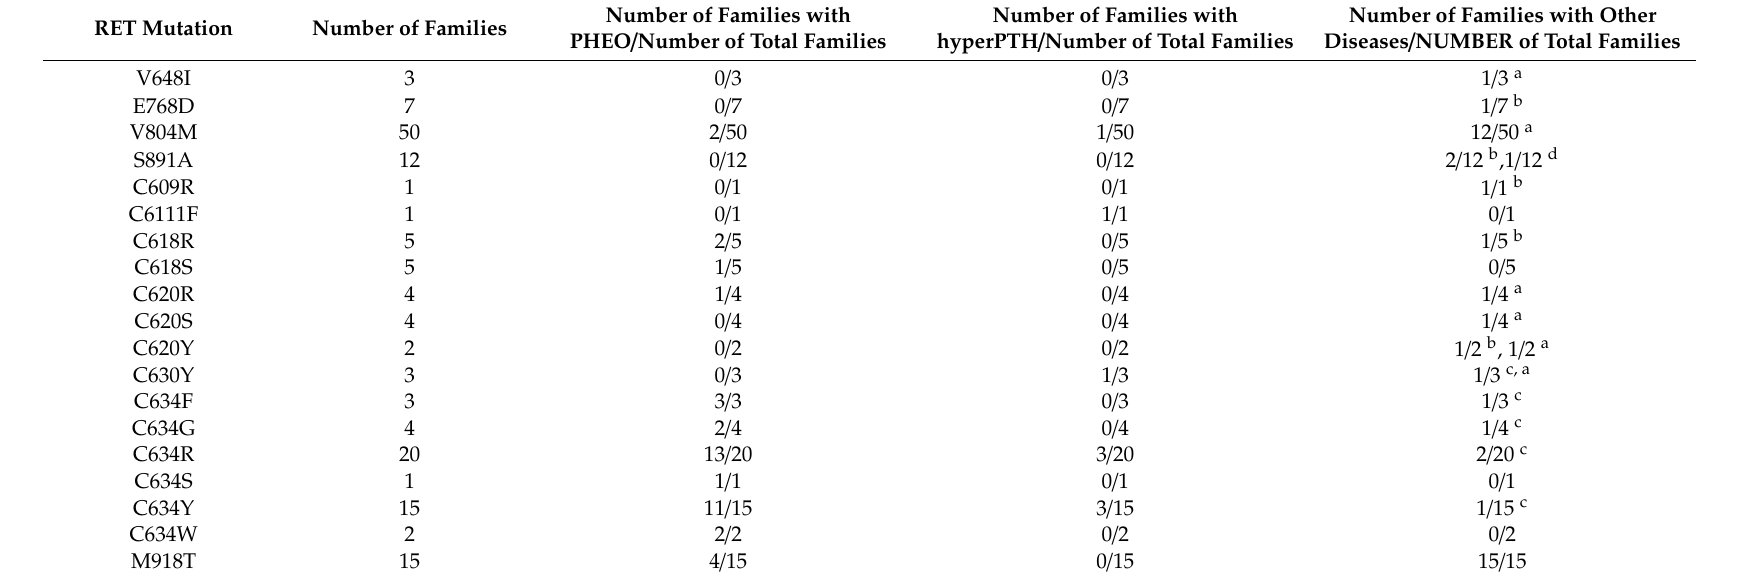
Table 2. Prevalence of endocrine and non endocrine clinical phenotypes according to the type of mutation: Only mutations associated with multiple diseases are